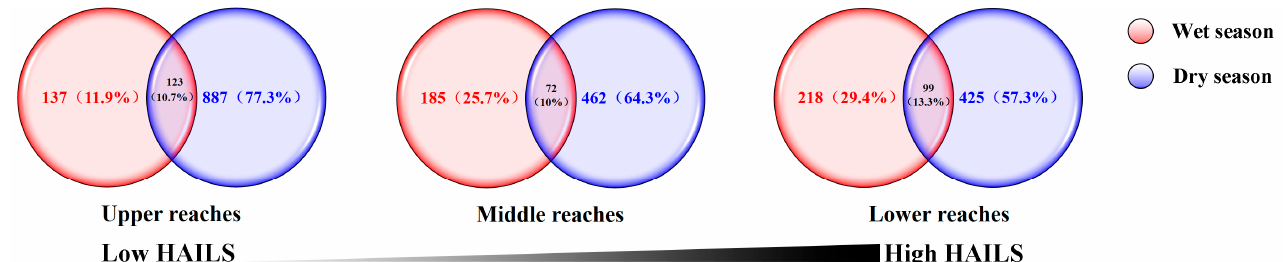
Figure 3. Molecular ecological networks of bacterial communities during the wet and dry seasons on Yuan River. Green and red lines denote significant positive (Spearman correlation, p < 0.05, r > 0.8) and negative (Spearman correlation, p < 0.05, r < − 0.8) linear relationships, respectively. The size of the circles represents the relative abundances of bacteria and the black line represents the categorical stress rankings of the three environments along the human activity intensity on the land surface.